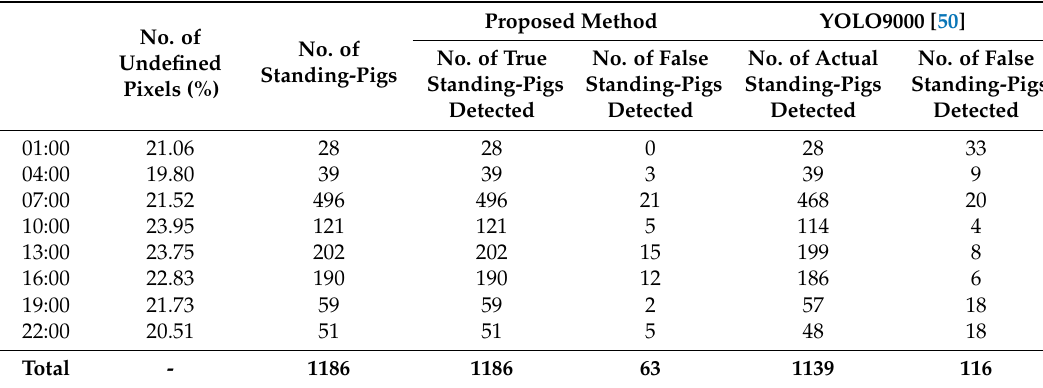
Table 4. Results for the detection of standing-pigs during daytime and nighttime.